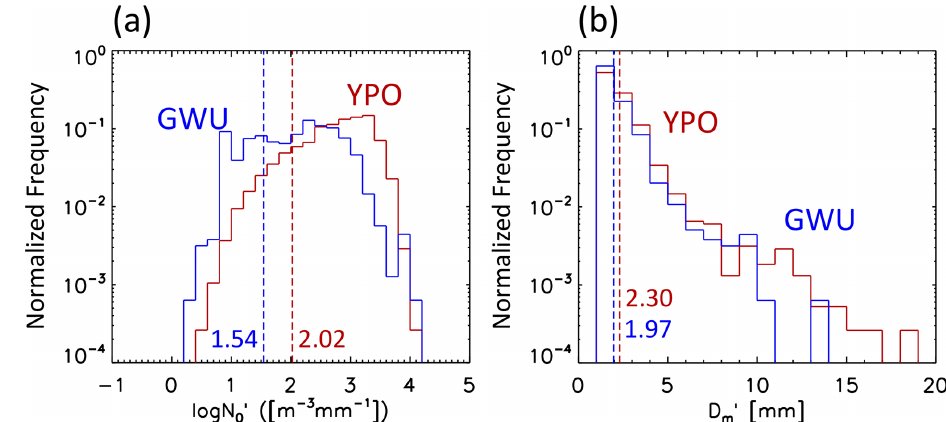
Figure 12. Same as in Fig. 5 except for the warm-low